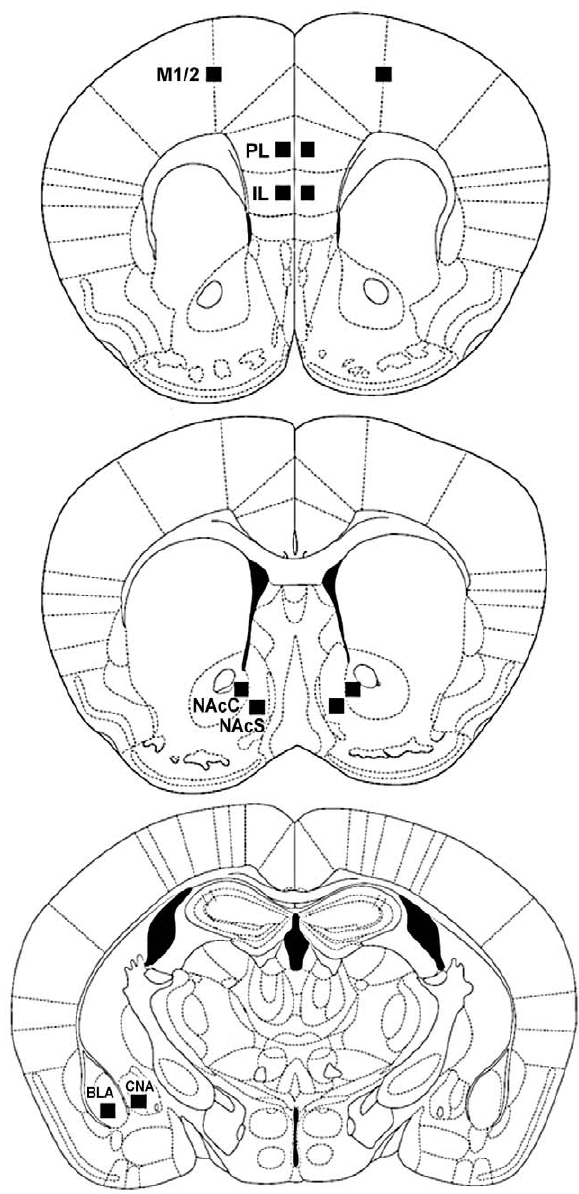
Figure 3. Schematic diagrams of coronal sections of mice brain illustrating where FosB/ D FosB immunoreactivity was quanti- fied in the following regions: prelimbic cortex (PL), infralimbic cortex (IL), motor cortex (M1/2), nucleus accumbens core (NAcC), nucleus accumbens shell (NAcS), caudate-putamen (CPU), central nucleus of amygdala (CNA) and basolateral amygdala (BLA). The black squares correspond to a fixed area 200 m m 6 200 m m in size.